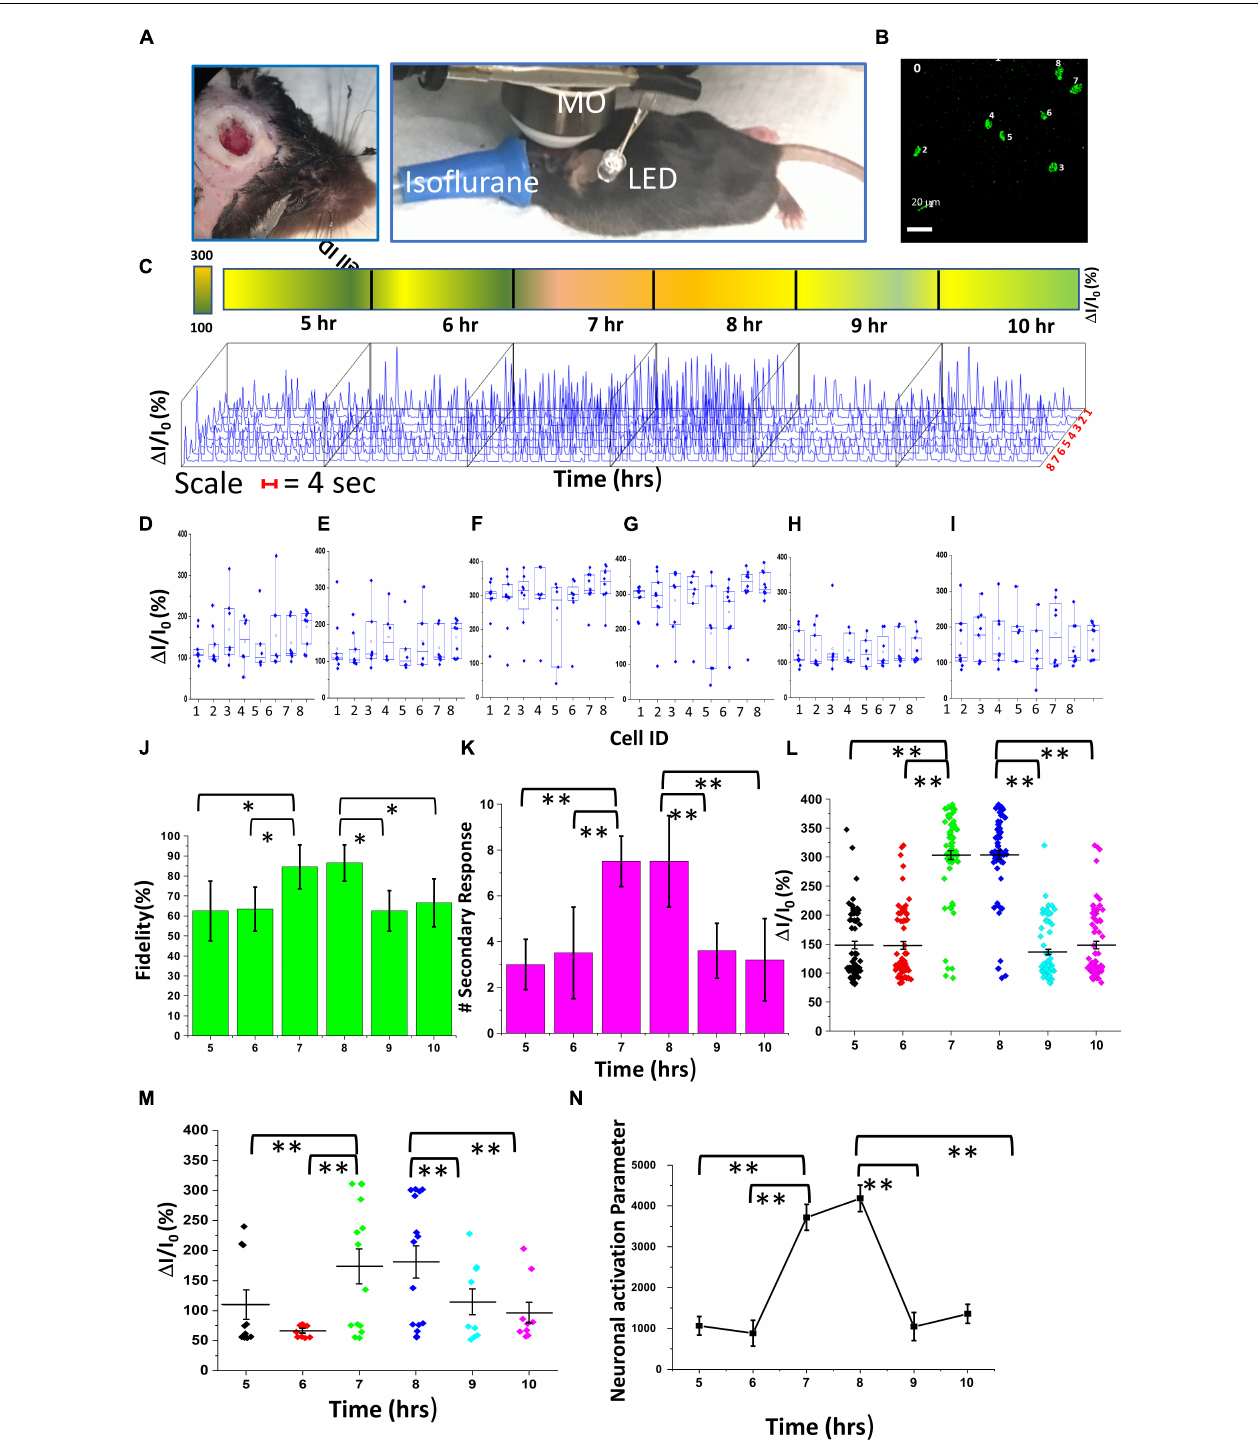
FIGURE 6 | Comparison of in vivo Ca 2 + bioluminescence activities and neural activation parameter in the visual cortex expressing bMCOII upon light stimulation at 5–10 h of recording. (A) Experimental setup for long-time recording of Ca 2 + bioluminescence signal. MO: microscope objective (25 × , NA = 1.05). (B) Ca 2 + bioluminescence image after 1st light stimulation at 0th hour showing the eight assigned neurons. (C) 3D plot of fractional change in Ca 2 + bioluminescence intensity for 10 stimulations at hours 5–10 during the experiment. (D–I) Box plots showing fractional change in Ca 2 + bioluminescence intensity at 5–10 h interval. (J) Fidelity. (K) Number of secondary responses. Scatter plot of fractional change in bioluminescence signal for (L) primary response and (M) secondary response, for various stimulation parameters. (N) Calculated neuronal activation parameter (NAP) at 5–10 h interval. N = 10 stimulations. Av. ± SD. ** p < 0.01; * p < 0.05.